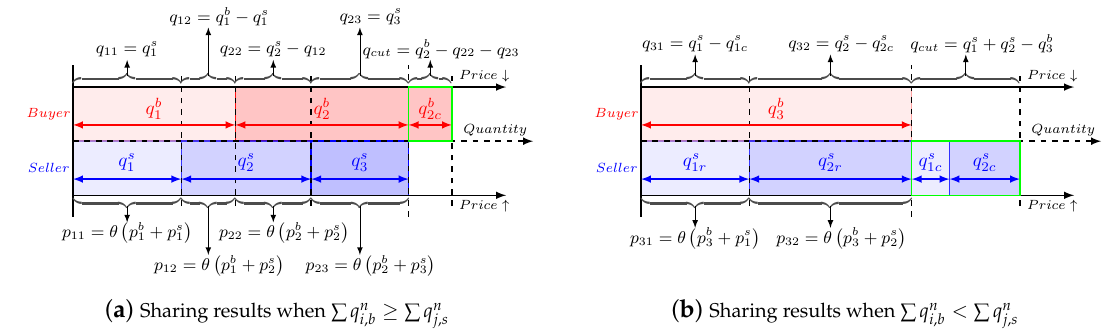
Figure 4. Sharing price and quantity under two